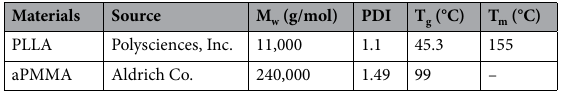
Table 1. Materials used and their physical